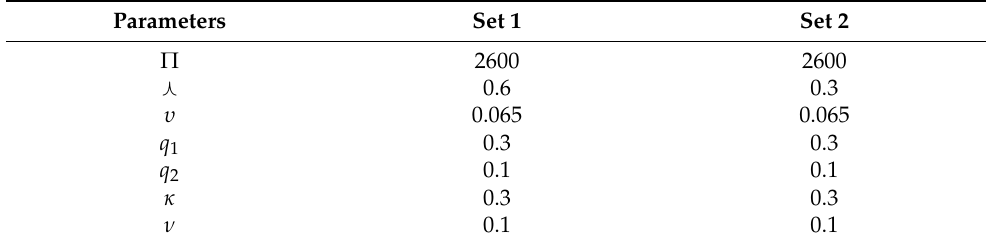
Table 1. The parameters and their values for model (2).